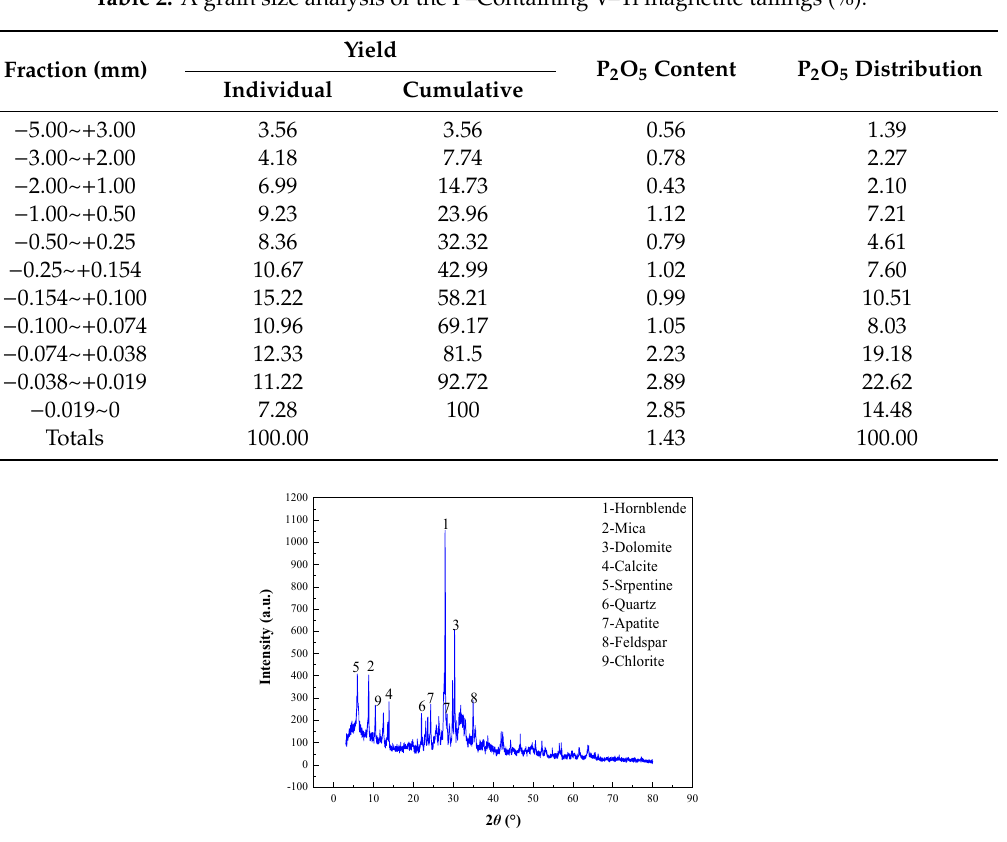
Figure 1. XRD di ff ractograms of the P-Containing V-Ti magnetite Figure 1. XRD diffractograms of the P-Containing V-Ti magnetite tailings.